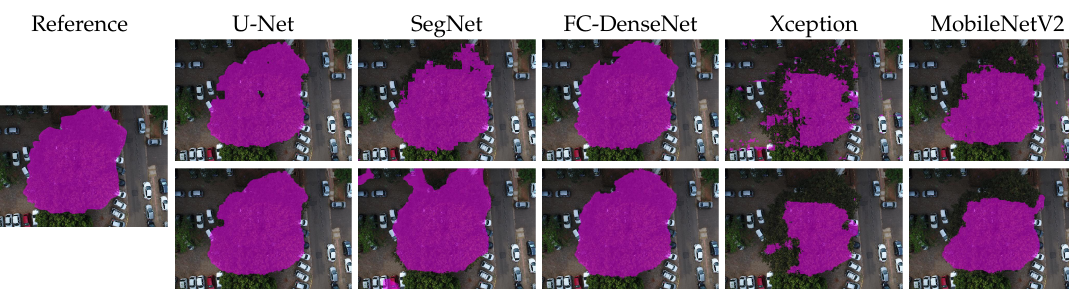
Figure 13. Sample Segmentation 4 prior (first row) and after CRF post-processing (second row).